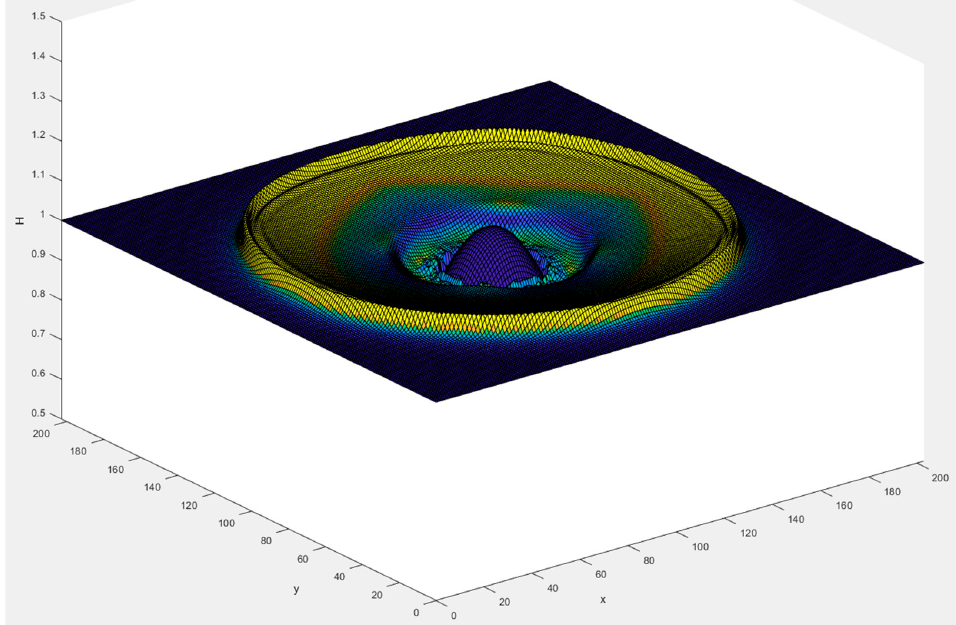
Figure 5. Contour plot of the water level at t = 33 s on a 196 m-by-196 m grid and an initial H of 1 m. Cell color is indicative of the total velocity in the cell, with dark blue being zero velocity and yellow high velocity. Table 1. Table of computation time of 1000 time steps in seconds for different grid sizes. The CPU rows are the computation times for the C++ CPU implementation for various